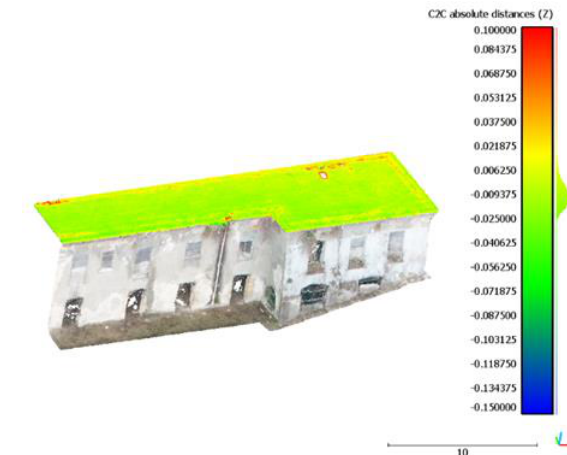
Figure 6 . Distances along the Z axis resulting from the Cloud- to-Cloud application, after registration the two point clouds by setting shift in the three directions x,y,z and rotation with respect to the z